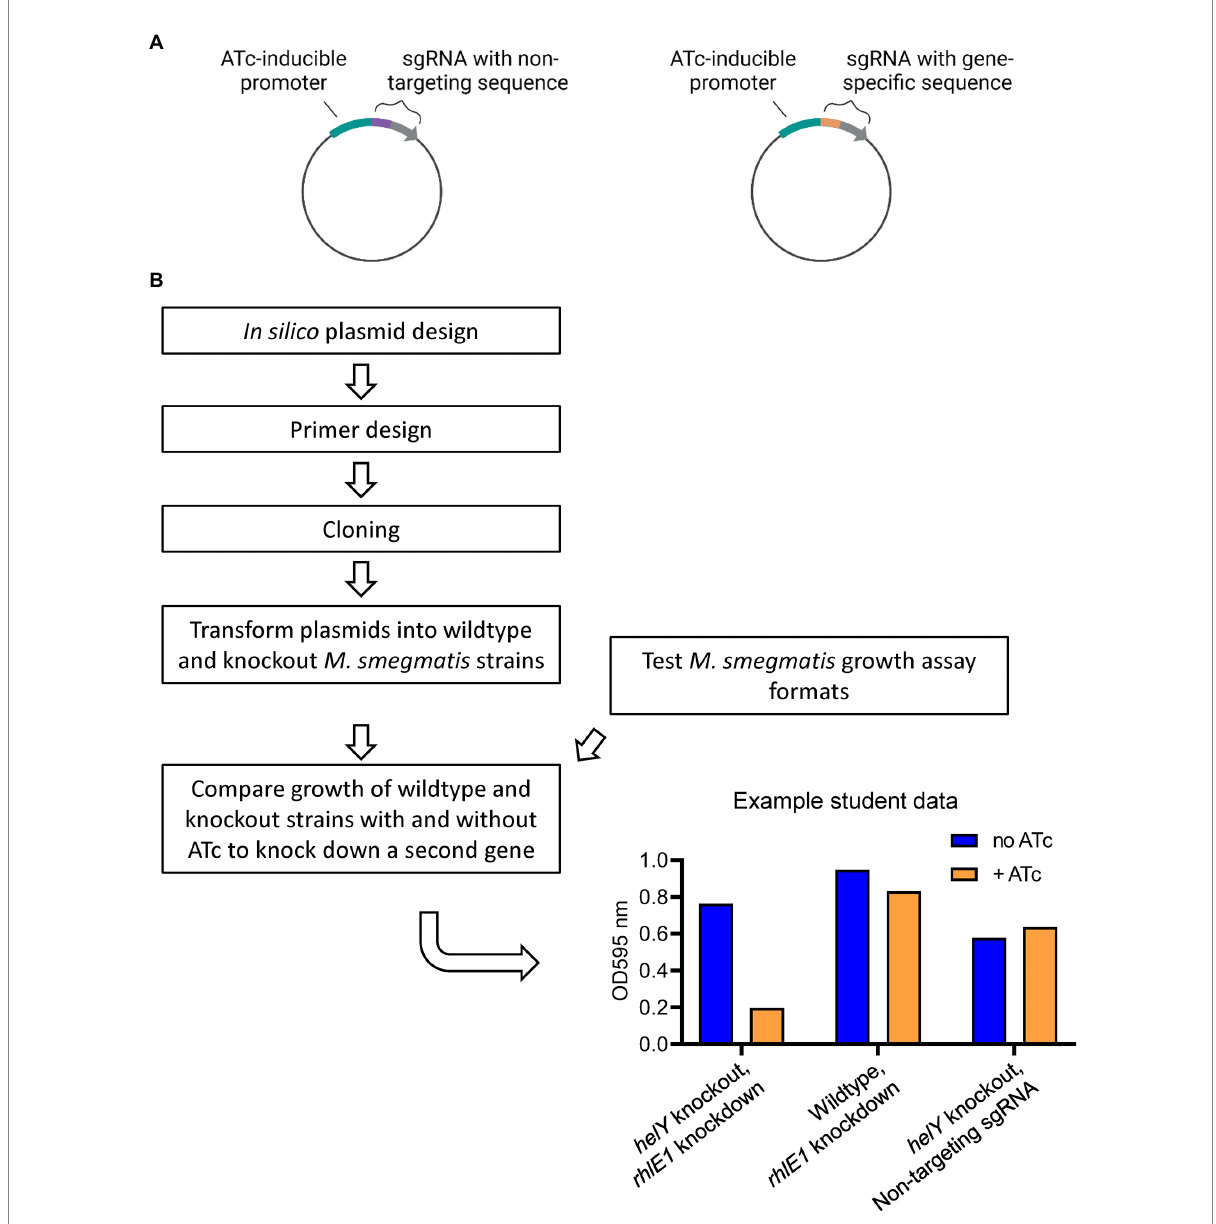
FIGURE 5 Research thrust 2: Using CRISPRi to access functional redundancy in RNA degradation proteins. (A) CRISPRi plasmids used to express catalytically dead Cas9 and sgRNAs. Students used HiFi assembly (NEB) to replace part of a non-targetting sgRNA with gene-specific sequence. Plasmid elements not shown include dcas9 , an E. coli origin of replication, and anibiotic resistence marker, and sequence to integrate the plasmid into the M. smegmatis chromosome by site-specific recombination. Expression of the sgRNA and dCase9 was controlled by ATc-inducible promoters. Graphics created with BioRender.com. (B) Student workflow for plasmid construction, strain construction, and measuring growth. An example is shown of student data testing for functional redundancy between the RNA helicases helicases HeIY and